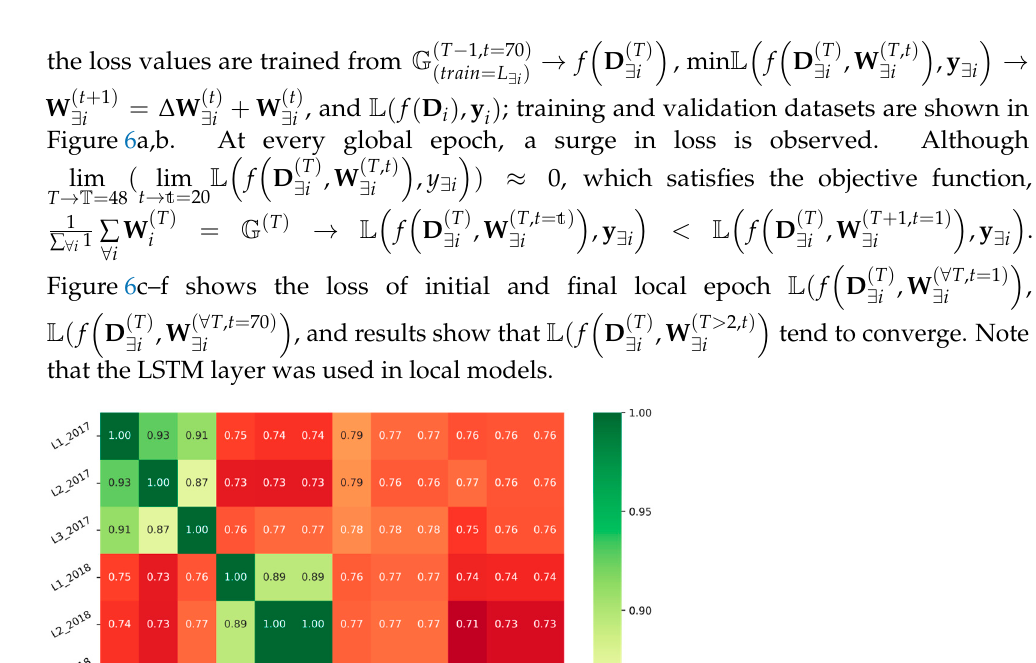
(cid:16) (cid:17) L ( i , year ) , L ( i (cid:48) , year (cid:48) )